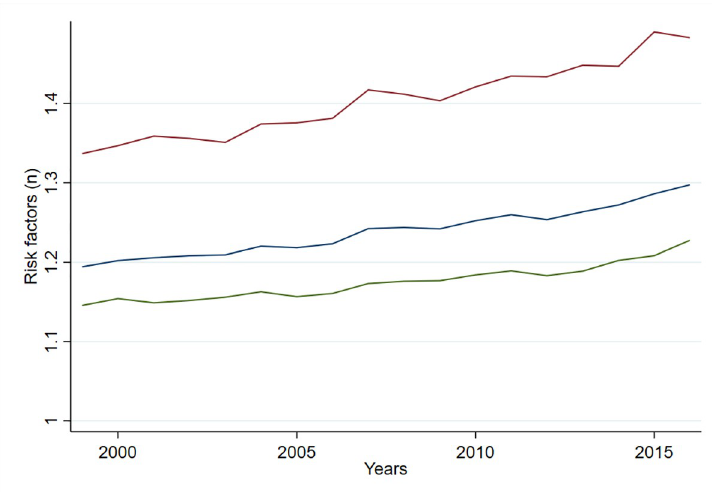
Fig 4. Mean number of selected risk factors per birth by year. All births (blue). Vaginal births (green). CS births (red). CS, cesarean section.